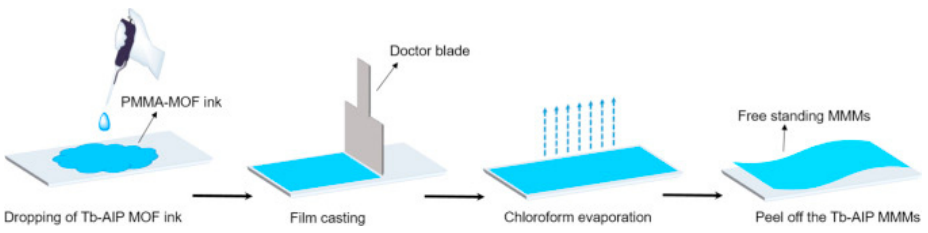
Figure 11. Schematic illustration for the preparation of Tb-AIP mixed matrix membranes (MMMs). Reprinted with permission from [100], Copyright (2017) Elsevier.